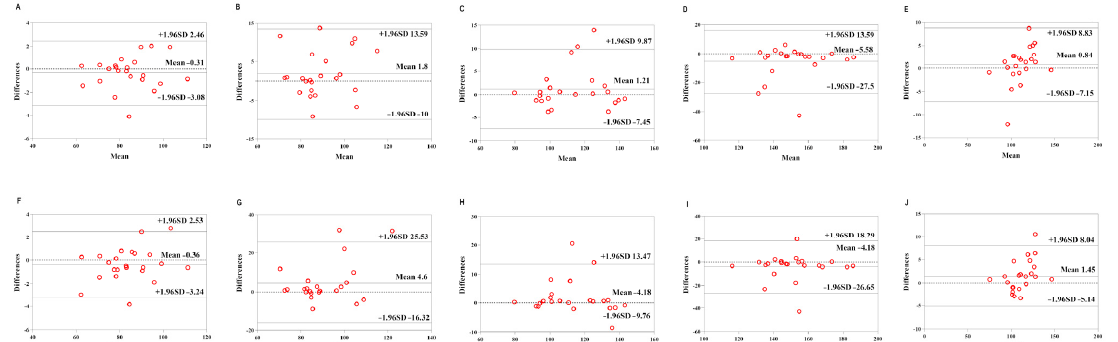
Figure 4. Comparison between the Lexin Mio smart bracelet (Mio) and Polar Heart Rate Monitor (Polar) for heart rate (HR) in the middle-physical-activity level (MPAL) group. ( A ) Bland–Altman plots of mean of left Mio and Polar for HR under rest condition. ( B ) Bland–Altman plots of mean of left Mio and Polar for HR under the low-intensity exercise. ( C ) Bland–Altman plots of mean of left Mio and Polar for HR under the middle-intensity exercise. ( D ) Bland–Altman plots of mean of left Mio and Polar for HR under the high-intensity exercise. ( E ) Bland–Altman plots of mean of left Mio and Polar for HR under recovery condition. ( F ) Bland–Altman plots of mean of right Mio and Polar for HR under rest condition. ( G ) Bland–Altman plots of mean of right Mio and Polar for HR under the low-intensity exercise. ( H ) Bland–Altman plots of mean of right Mio and Polar for HR under the middle-intensity exercise. ( I ) Bland–Altman plots of mean of right Mio and Polar for HR under the high-intensity exercise. ( J ) Bland–Altman plots of mean of right Mio and Polar for HR under recovery